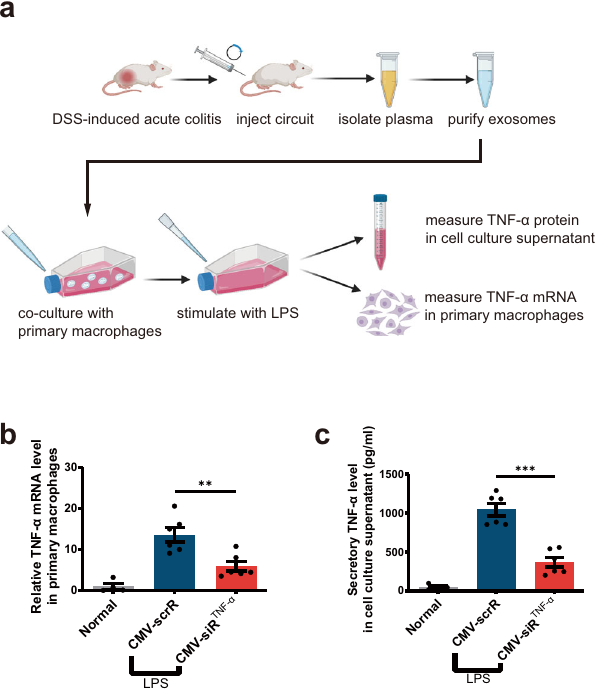
Fig. 3 | Evaluation of the activity of TNF- α siRNA-encapsulating sEVs in an ex vivo model. a Schematic of the experimental design. Acute UC was induced in male BALB/c mice by replacing their drinking water with a 2.5% DSS solution for 7 days. DSS mice were intravenously injected with 5mg/kg CMV-scrR or CMV- siR TNF- α circuiteverydayforatotalof7times,andthenthesEVswerepuri fi edfrom theplasmaofeachmouseanddissolvedin50 µ LPBS.BCAmethodwasemployed toquantifytotalproteincontentinsEVs, andtheisolatedsEVshadatotalprotein concentration of ~0.8 μ g/ μ L. Subsequently, the sEV solution (50 µ L) was incu- bated with 1 × 10 5 primary macrophages. After stimulating macrophages with 50ng/mL LPS, the suppression of TNF- α expression by TNF- α siRNA were examined in this ex vivo model. b Quantitative RT-PCR analysis of the relative expression levels of TNF- α mRNA in primary macrophages ( n =6 in each group). Created with BioRender.com. c Determination of the levels of secretory TNF- α protein in cell culture supernatant by ELISA ( n =6 in each group). Values are presentedasthemean±SEM.Signi fi cancewasdeterminedusingone-wayANOVA followed by Dunnett ’ s multiple comparison. ** p <0.01; *** p